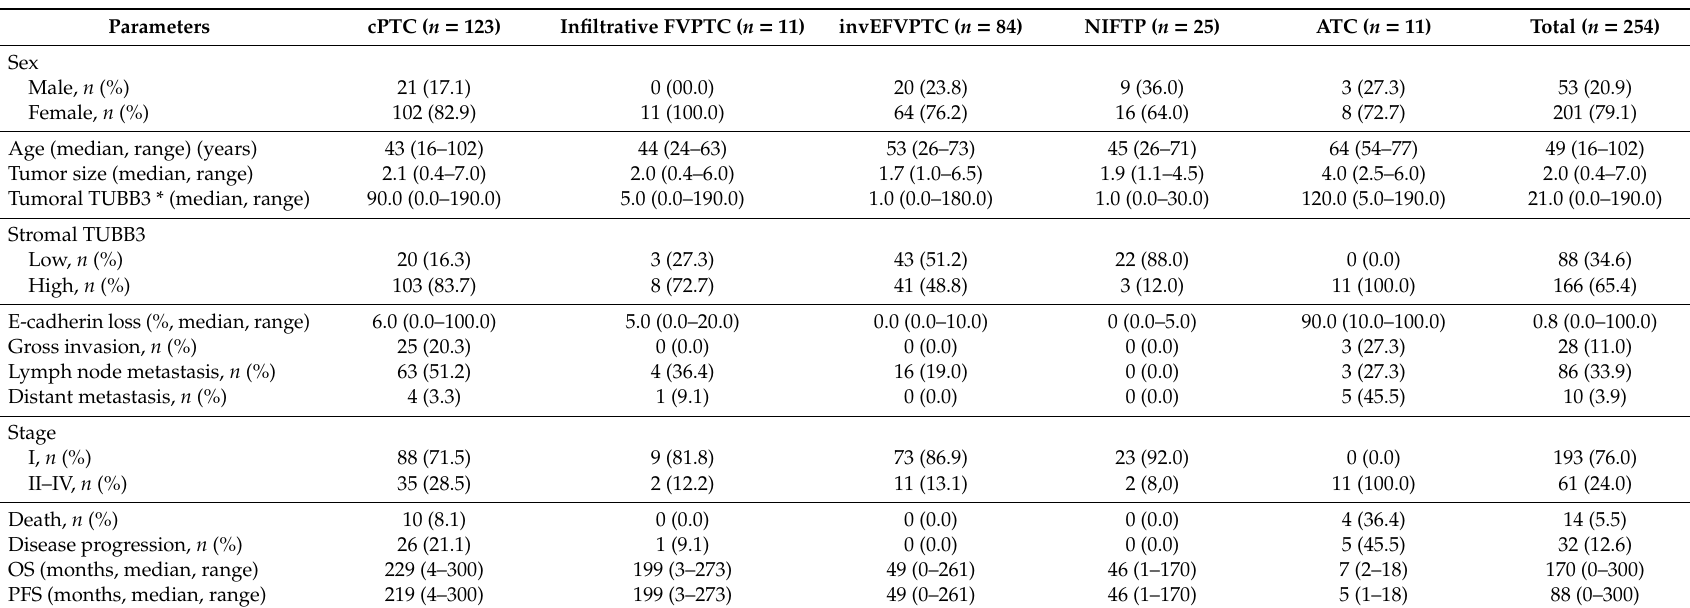
Table 1. Clinicopathological parameters in di ff erent thyroid